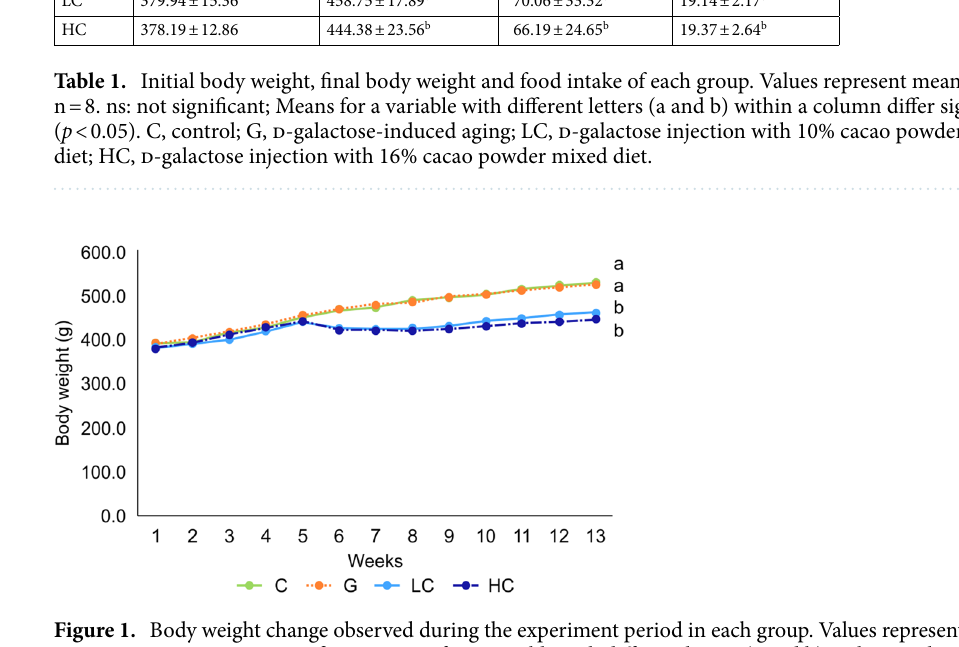
Figure 1. Body weight change observed during the experiment period in each group. Values represent mean ± SD, n = 8. ns: not significant; Means for a variable with different letters (a and b) within a column differ significantly ( p < 0.05). C, control; G, d-galactose-induced aging; LC, d-galactose injection with 10% cacao powder mixed diet; HC, d-galactose injection with 16% cacao powder mixed